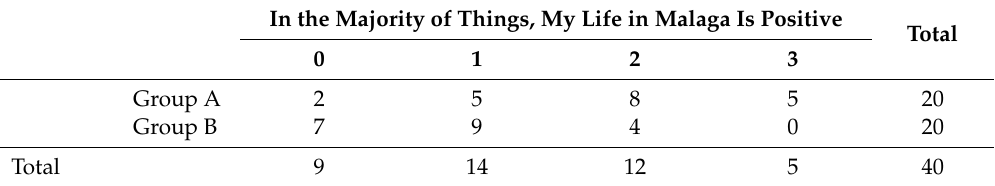
Table 9. E ff ect of the learning group in the subjective evaluation of life in Malaga *.